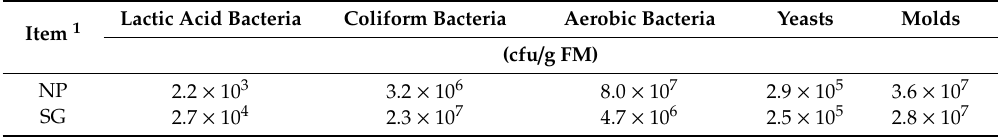
Table 1. Microbial counts of fresh Napier grasses at the late maturity stage used in this study.